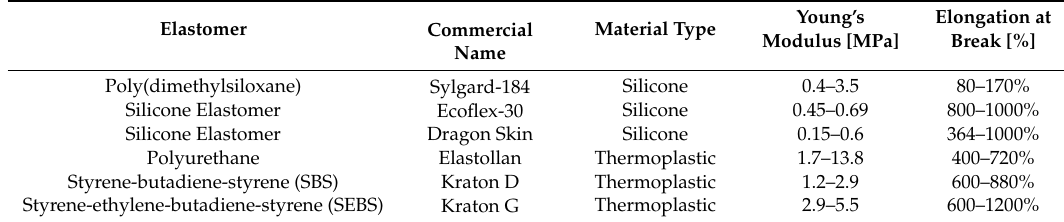
Table 1. Mechanical properties of common elastomers (from their technical data